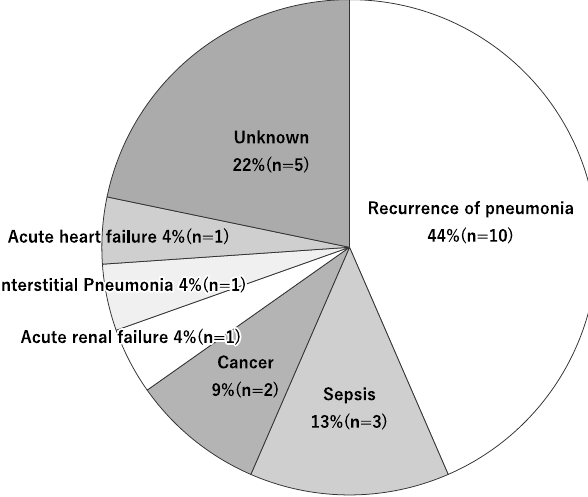
Figure 3 Causes of in-hospital death in patients who improved after NHCAP. NHCAP, nursing and healthcare-associated